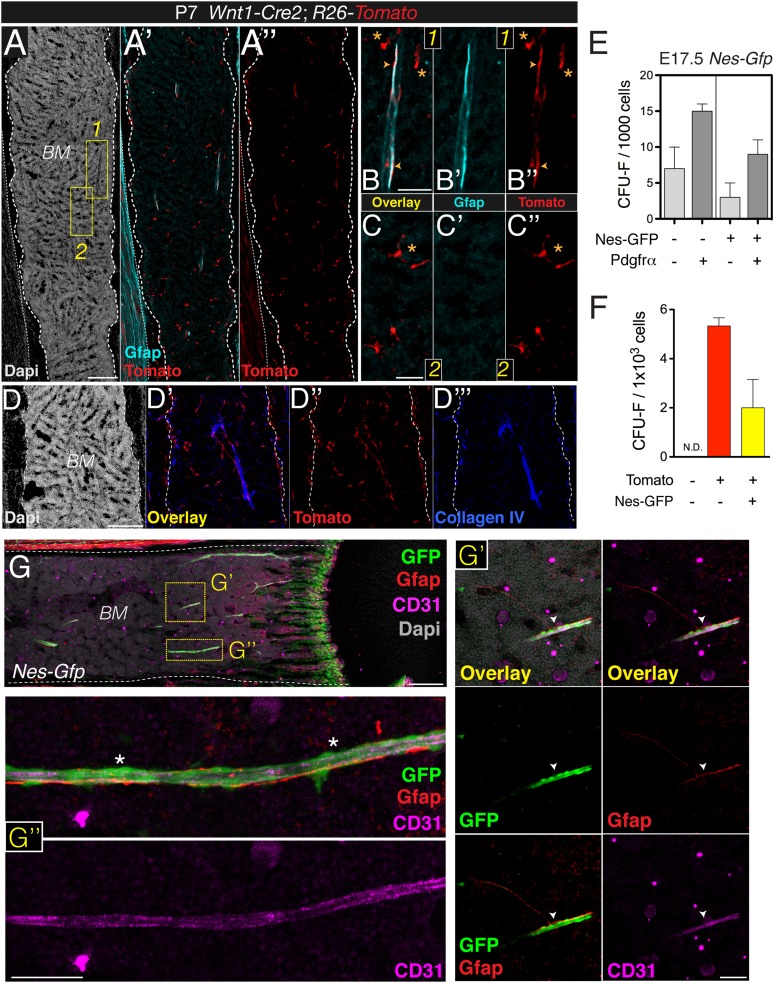
Bone marrow Nes-GFP+ cells are distinct from mature Schwann cells.(A–C) Diaphysis section stained with antibodies against glial fibrillary acidic protein (Gfap, cyan). Neural crest-traced cells included Gfap+ Schwann cells (inset 1, arrowheads) and Gfap− putative BMSCs (inset 2, asterisks) (B-B′′, C-C′′). (D-D′′′) Staining of basal lamina with collagen IV antibodies (blue) showing close association of neural crest-derived cells (red) with blood vessels. (E) Surface expression of Pdgfrα enriches for fetal bone marrow mesenchymal progenitors. Fibroblast colony-forming units (CFU-F) in bone marrow stromal cells (CD45- CD31- Ter119-) isolated from E17.5 Nes-Gfp mice according to GFP and Pdgfrα expression. (F) Frequency of CFU-F colonies obtained from sorted populations of Wnt1-Cre2;R26-Tomato;Nes-Gfp 1-week old pups. (G) Schwann cells are closely associated with distinctive Nes-GFP+ perivascular cells (arrowheads). Immunofluorescence of P9 Nes-Gfp tibial bone marrow showing GFP+ cells (green), Gfap+ Schwann cells (red), and CD31+ endothelial cells (pink); nuclei were counterstained with DAPI (gray). (G′–G′′) Details of central diaphyseal region (insets) at high magnification. (G′) Note the long Gfap+ Schwann cells extending through the arteriole, surrounded by distinctive Nes-GFP+ cells (arrowhead). (G′′) Magnified view of a long arteriole. Asterisks indicate Gfap- perivascular Nes-GFP+ cells. Scale bars: 200 μm (A, D, G), 50 μm (B, C, G′–G′′).